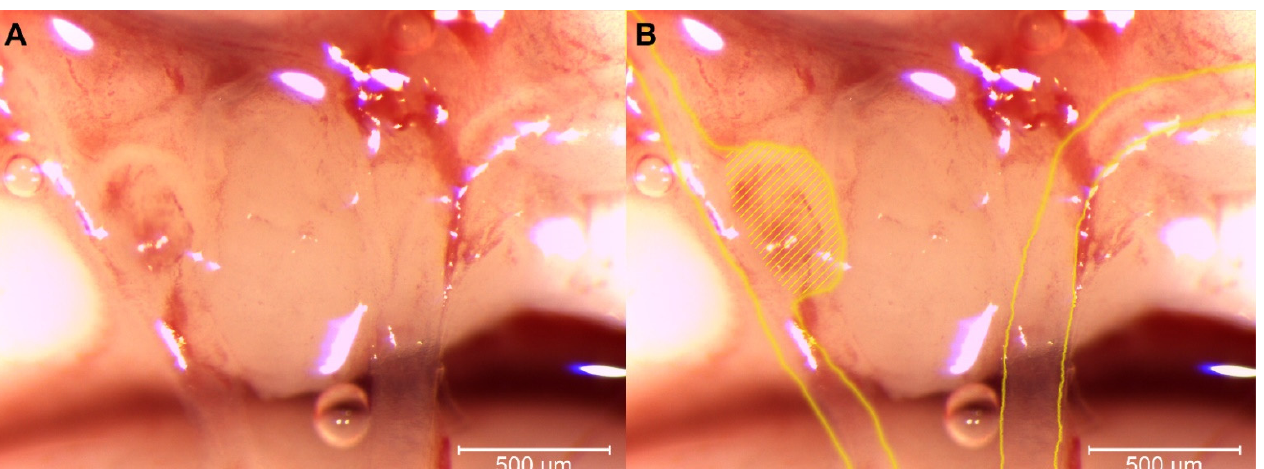
ies [32]. A saccular aneurysm with detritus evolved at the right posterior communicating artery. Original picture. ( B ) Marked left and right posterior communicating artery with a saccular